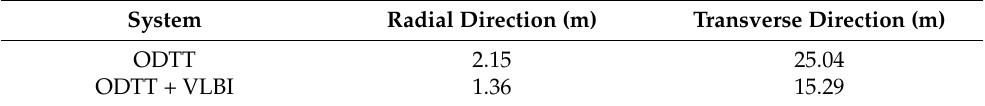
Table 2. PDOP in different directions of the